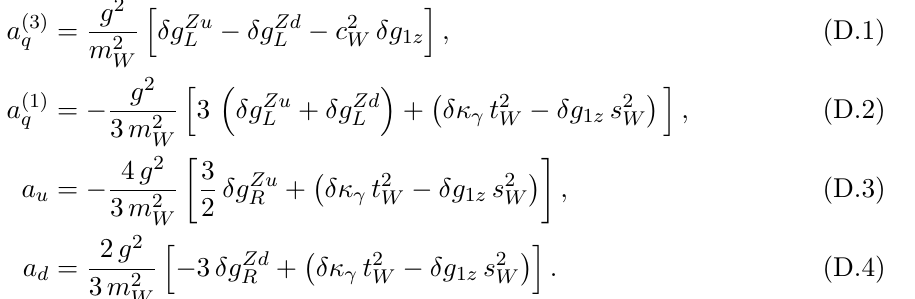
Figure 15 . 95% CL contours for the aTGCs marginalizing over all other parameters. A three parameter (cid:12)t (dashed or dotted) with (cid:14)V (cid:22) qq = 0 and a seven parameter (cid:12)t (solid lines) combined LHC diboson data and LEP-1 data are performed. For the later (cid:12)t, a FU setup is considered. The blue lines are our results, in black the results obtained in ref. [10], and in red, our results taking into account only the last